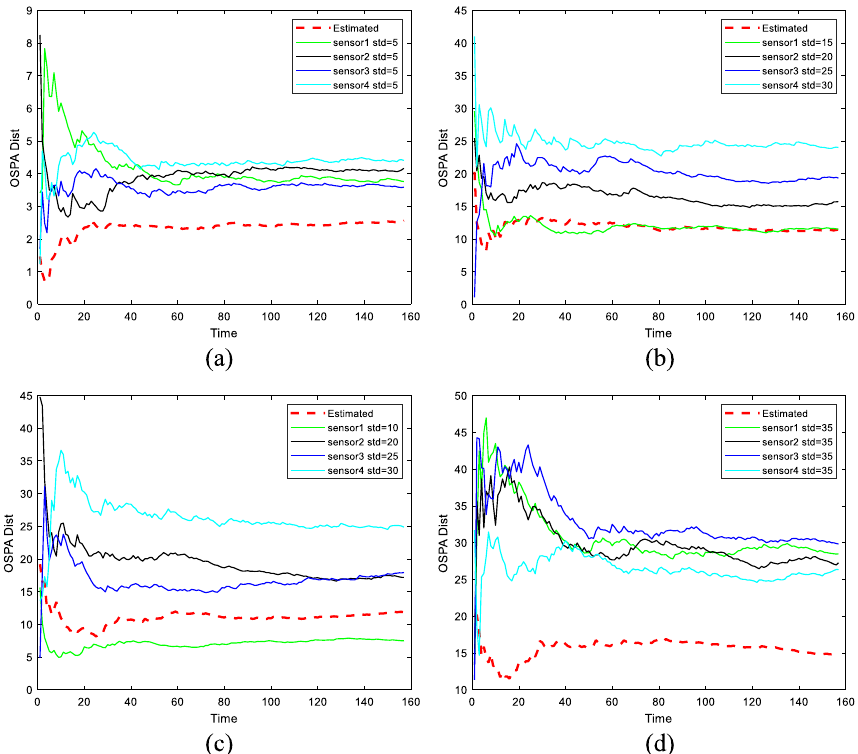
Fig. 9 Influence of measurement quality on estimation results